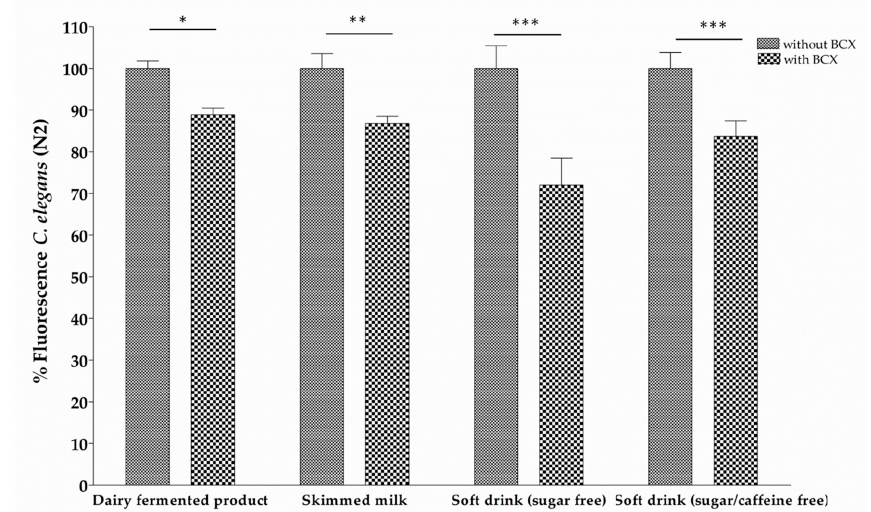
Figure 4. Body fat reduction measured by Red Nile staining in C. elegans worms fed with different food matrices supplemented with β -Cryptoxanthin (BCX) at 0.025 µ g/mL. Nematode growth medium (NGM) was used as control feeding condition and Orlistat (6 µ g/mL) as positive control. Percentage of fluorescence is the mean of two independent experiments. *** Significant p -value ≤ 0.001, ** Significant p -value ≤ 0.01, * Significant p -value ≤